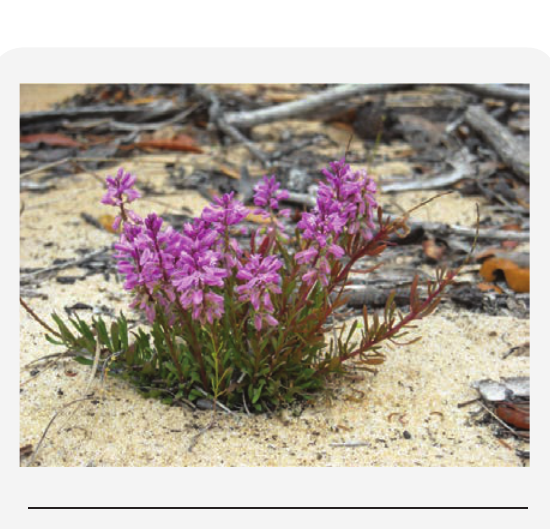
Figure 8. The showy, aboveground chasmogamous fl owers of Polygala lewtonii. Results of genetic analyses show that the showy fl owers do not show high rates of outcrossing and that most reproduction arises from self-fertilization or inbreeding. Photo by Carl